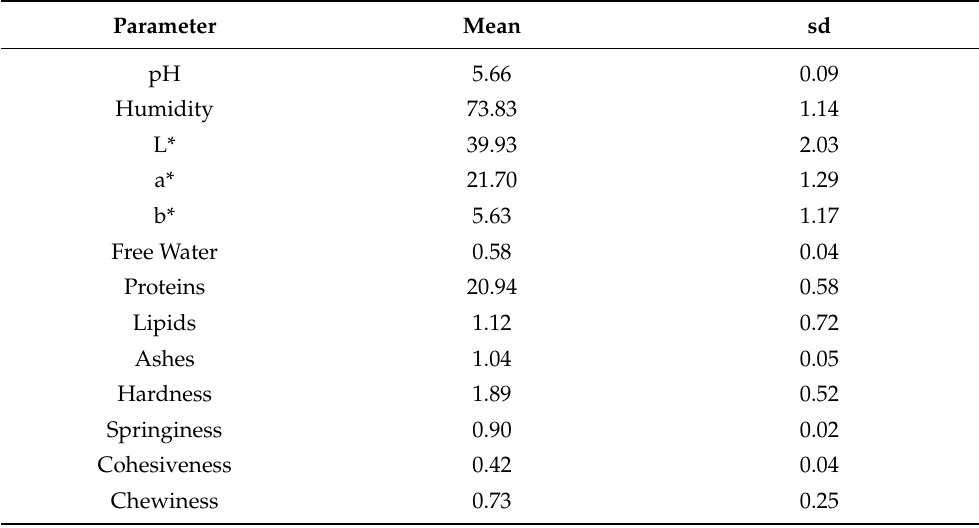
Table 1. Descriptive statistics (mean and standard deviation) of the parameters investigated, where L* represents the lightness, a* the redness, and b* the